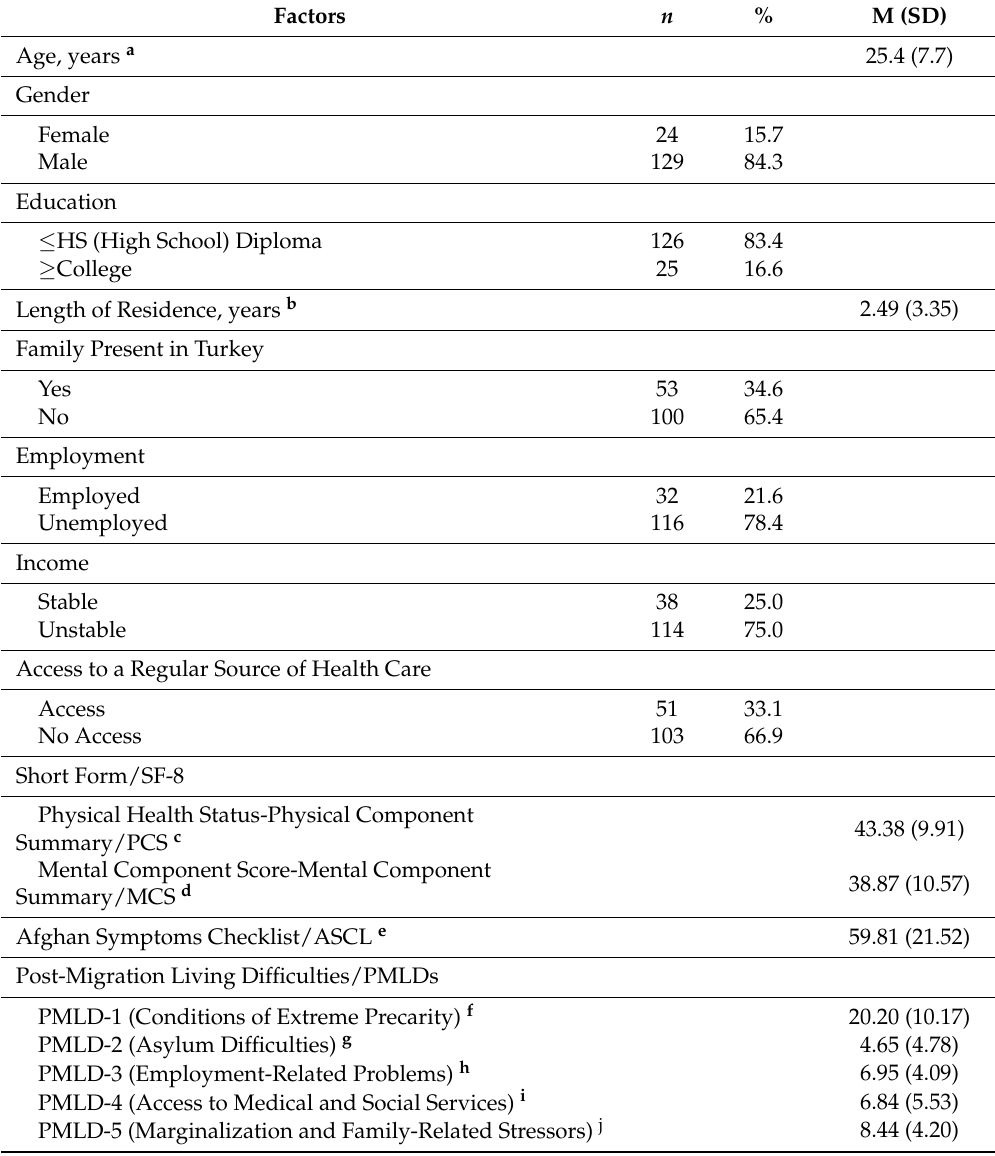
Table 1. Socio-demographic characteristics ( n =